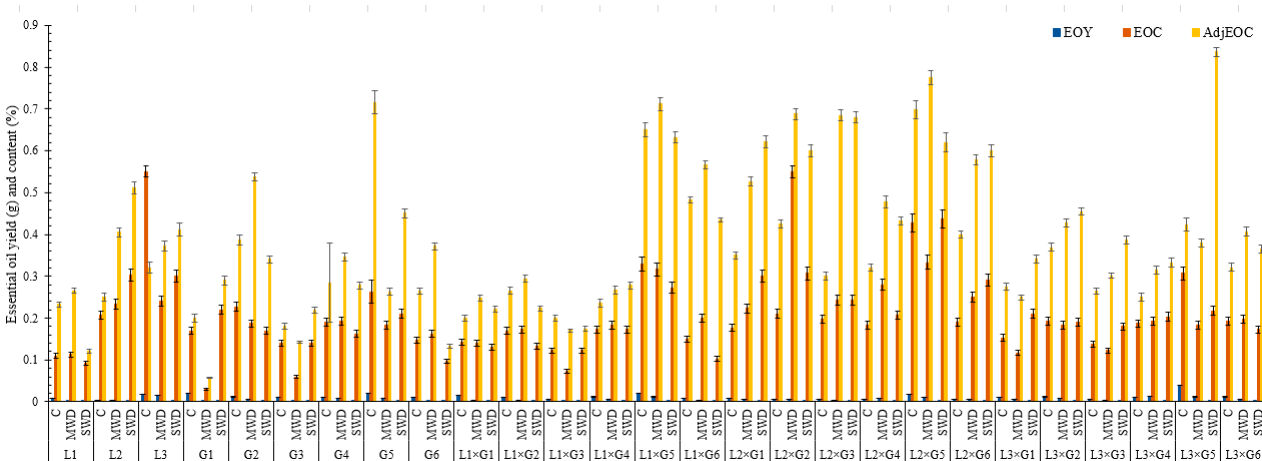
Figure 6. Water treatment (WT) × genotype interaction effect on dehulled seed fatty acid content (DSFAC), hull fatty acid content (HFAC), and whole fatty acid content (FAC). C: control; MWD: moderate water deficit; SWD: severe water deficit. L 1 –L 3 : 3 testers, G 1 –G 6 : 6 male parents; L 1 G 1 –L 2 G 6 : 12 single hybrids, and L3G1–L3G6: 6 three-way hybrids in a modified triple test cross.